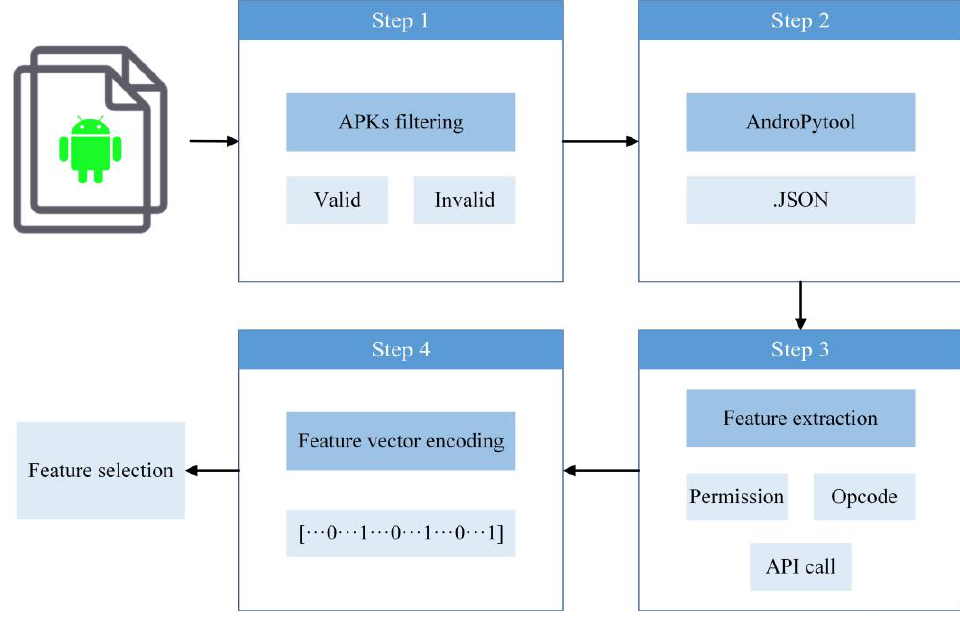
Figure 2. The process of data preprocessing. Table 3. Representation of feature